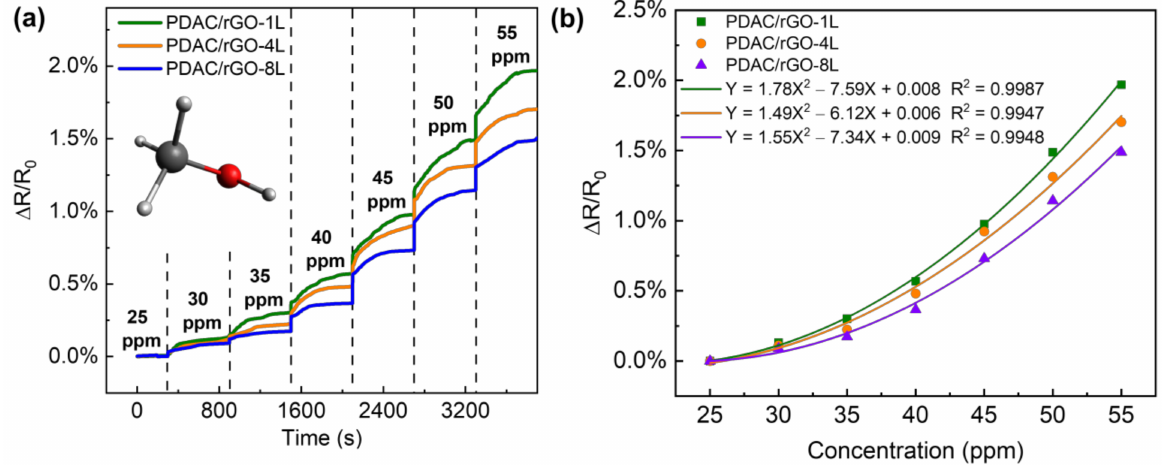
Figure 5. Response curve of the PDAC/rGO sensor to methanol gas ( a ) step response with time and ( b ) calibration